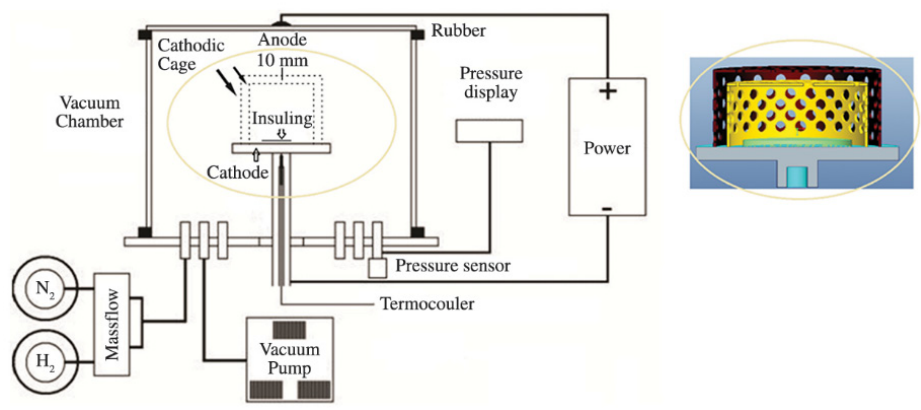
Figure 1. Cross-section of ion nitriding reactor with a cathode cage